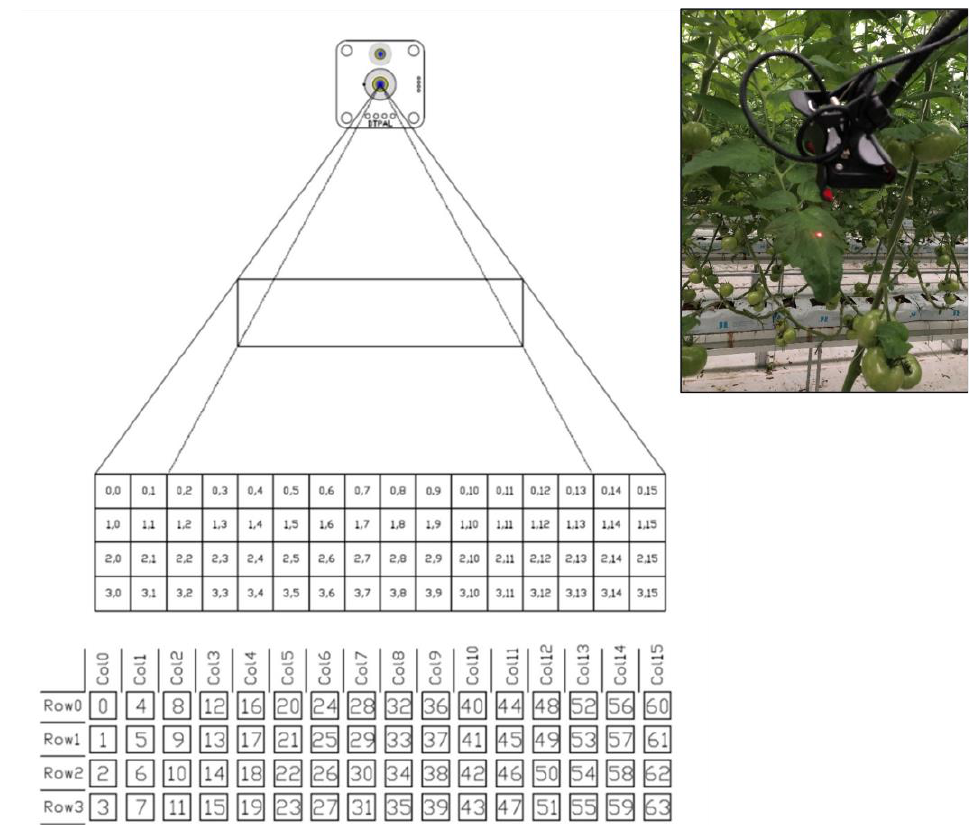
Figure 2. Conventional “smart farm” approaches used for sensor configuration, communication, and data management ( a ) and alternative approaches with the addition of leaf temperature moni- toring ( b ).